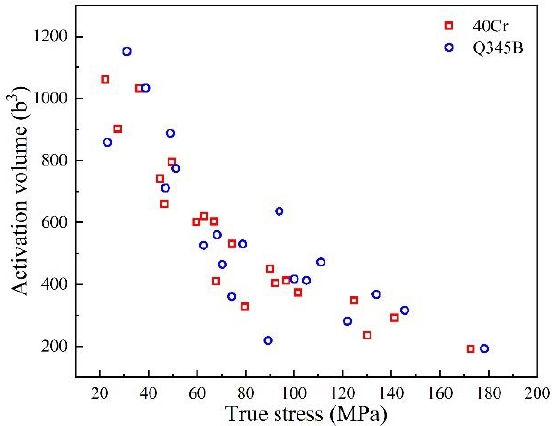
Figure 12. Activation volumes of 40Cr and Q345B.